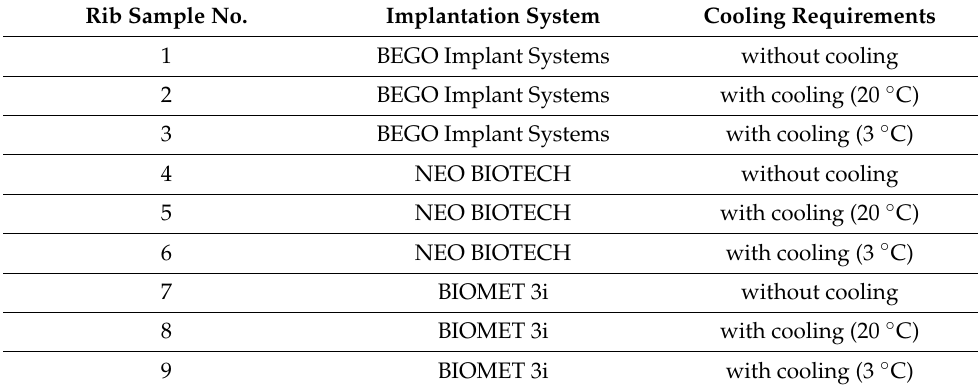
Table 1. Variants of the used drilling systems. Rib Sample No. Implantation System Cooling Requirements 1 BEGO Implant Systems without cooling 2 BEGO Implant Systems with cooling (20 ◦ C) 3 BEGO Implant Systems with cooling (3 ◦ C) 4 NEO BIOTECH without cooling 5 NEO BIOTECH with cooling (20 ◦ C) 6 NEO BIOTECH with cooling (3 ◦ C) 7 BIOMET 3i without cooling 8 BIOMET 3i with cooling (20 ◦ C) 9 BIOMET 3i with cooling (3 ◦